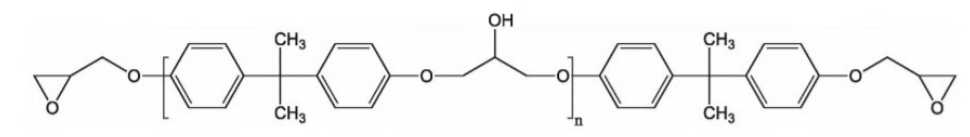
Figure 1. Chemical structures of epoxy resin.